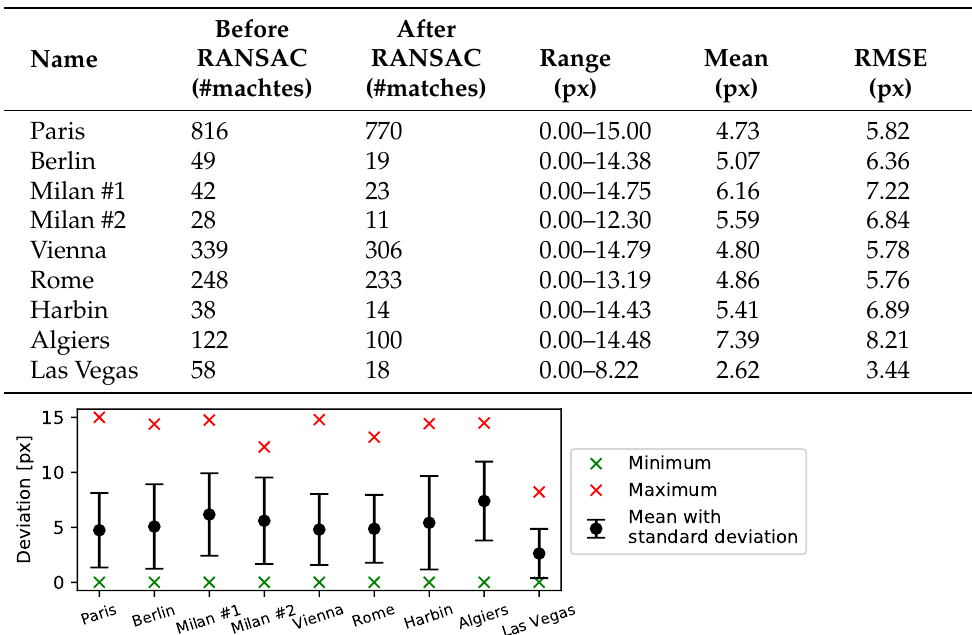
Table 2. Matching